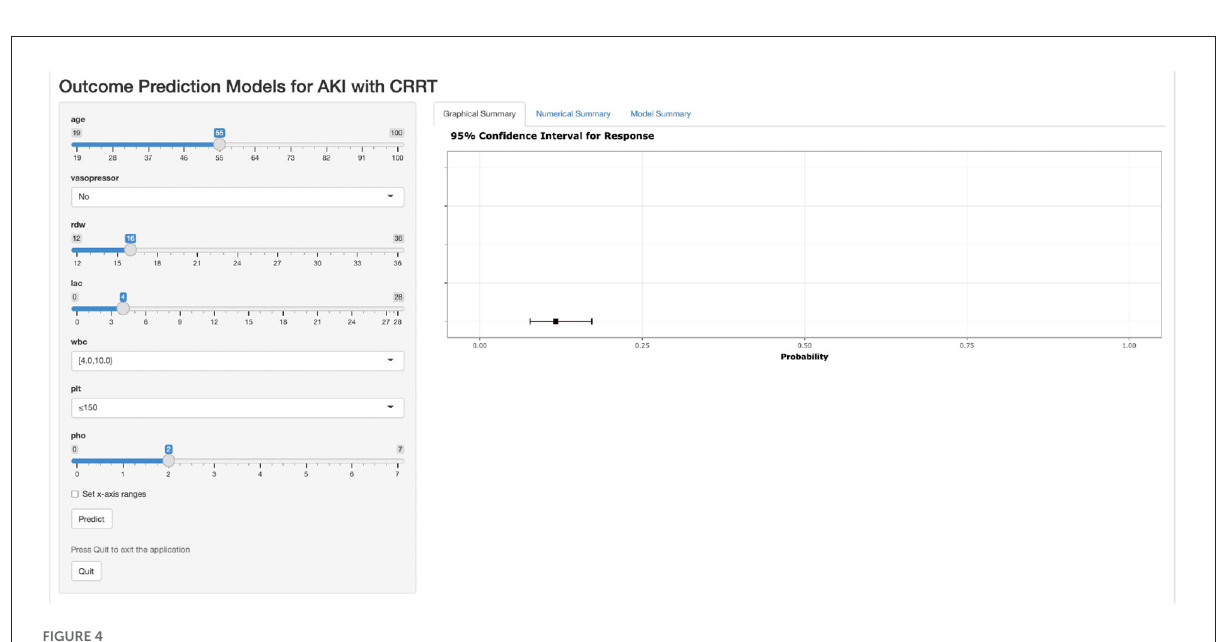
FIGURE4 The web-based prognostic calculator.